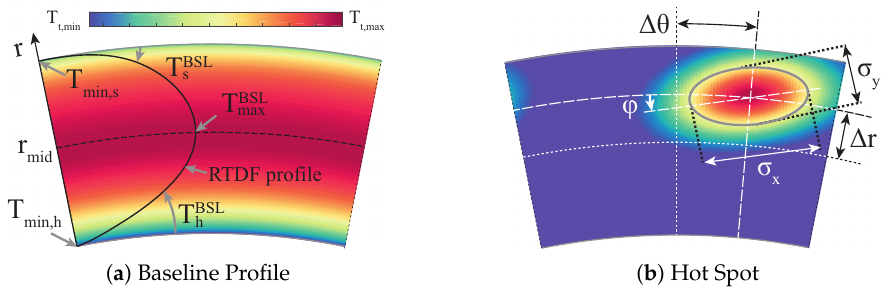
Figure 6. Parameterisation of the temperature field. RTDF: radial temperature distortion factor.